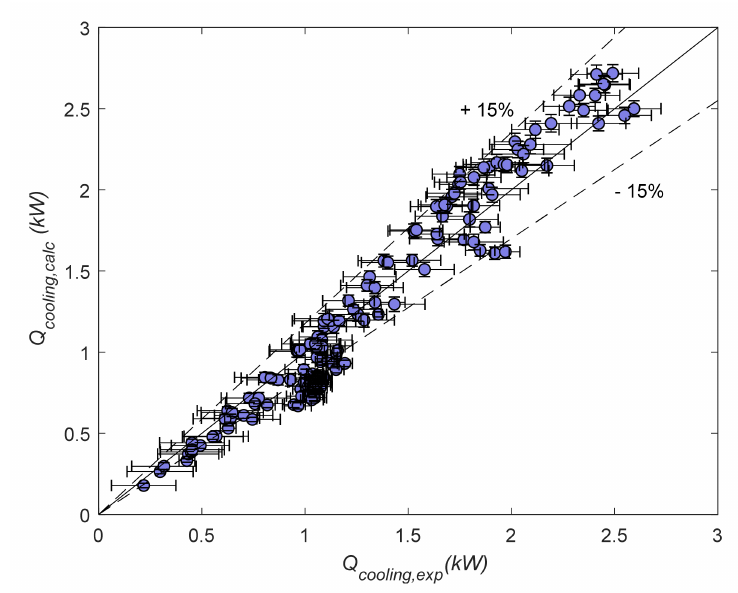
Figure 5. Predicted cooling capacity vs. the experimental cooling capacity.